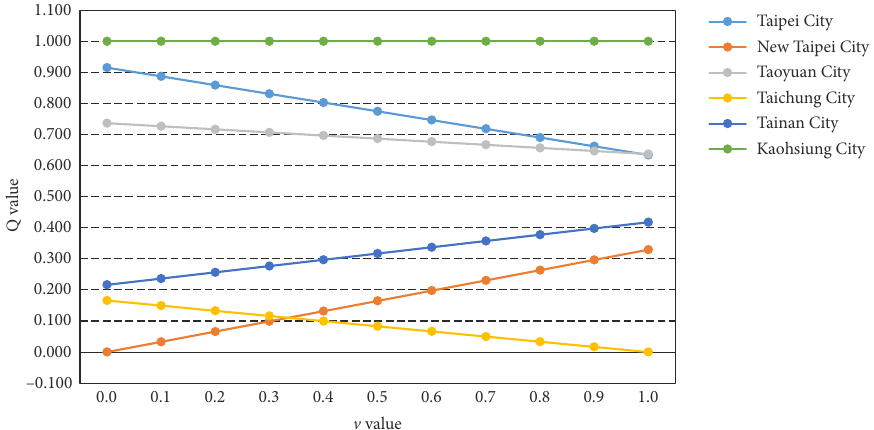
Figure 10. Simulation of the six cities for different v value in government support